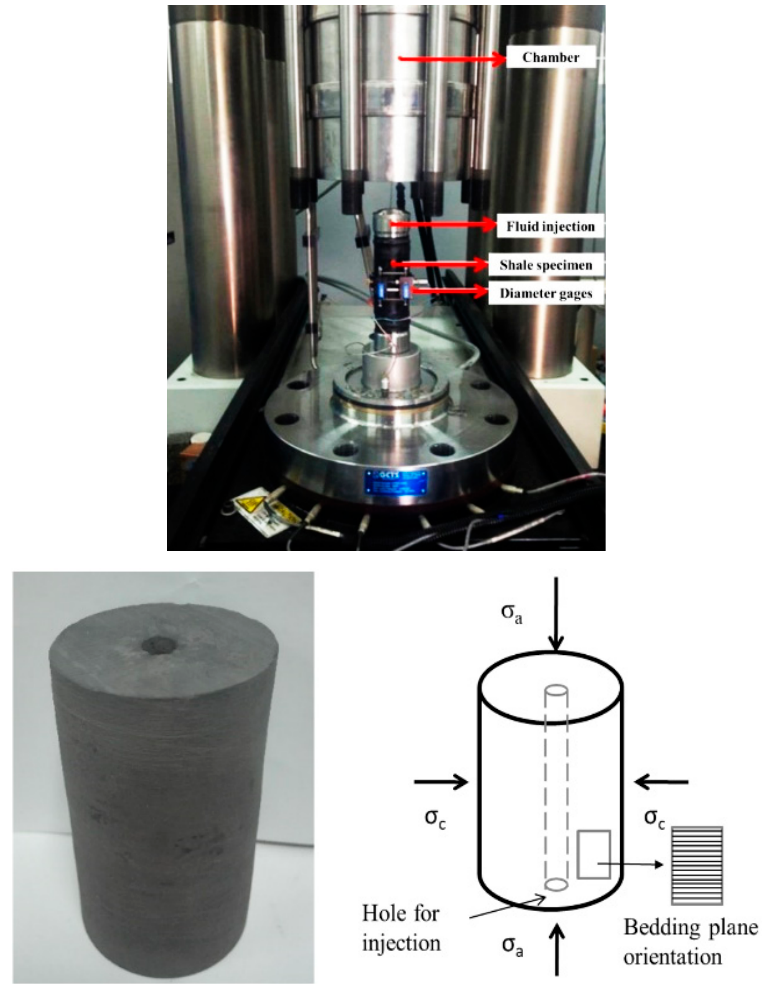
Figure 1. The experimental scheme and shale specimen